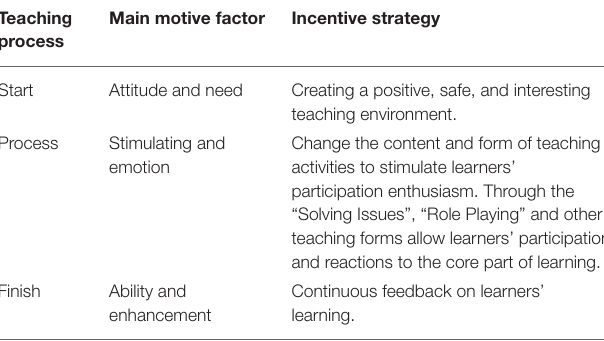
TABLE 2 | Application of time continuous model in specific